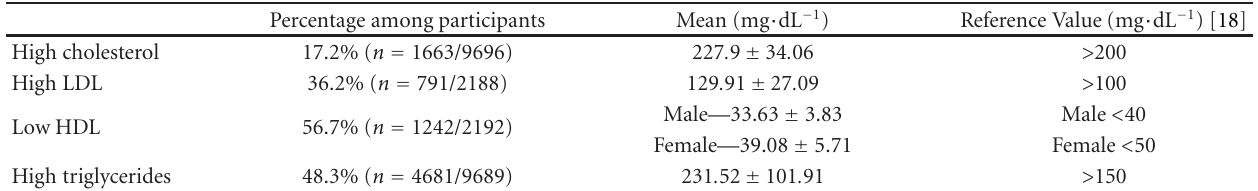
Table 3: Percentage of participants’ abnormal lipid